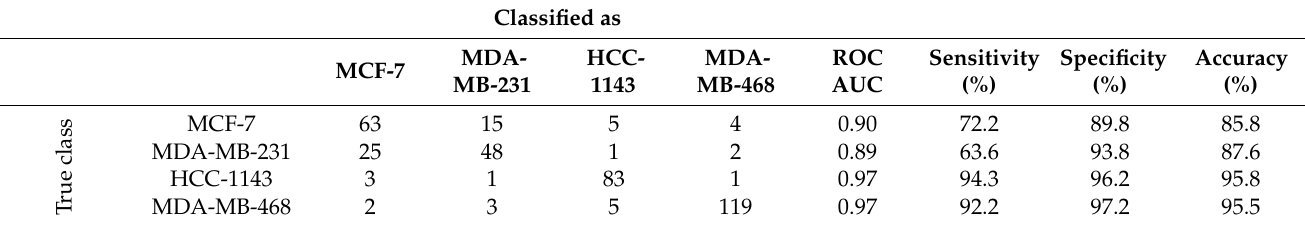
Table 3. Confusion matrix of RF classification model on independent Raman data (fingerprint region) using the 25% held-out validation method, and respective performance metrics (ROC area, sensitivity, specificity and overall accuracy) of the model towards each group of samples (true